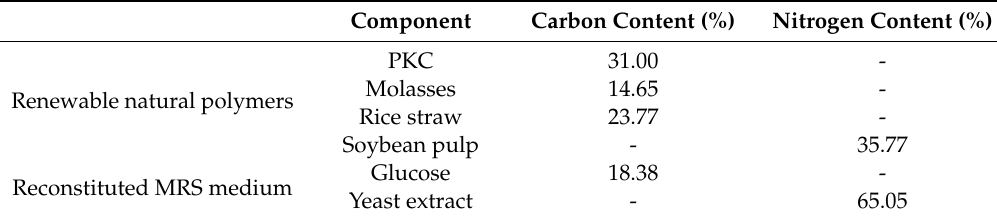
Table 3. Carbon and nitrogen contents for renewable natural polymers employed in this